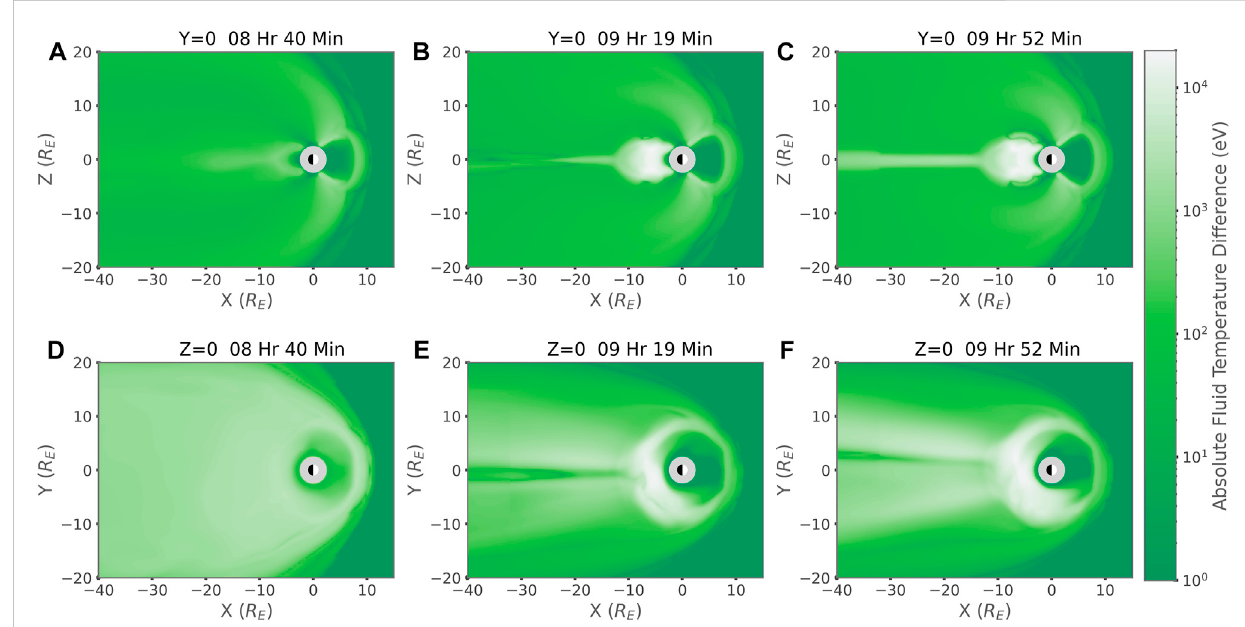
FIGURE 6 Absolute temperature difference of the plasmasphere fl uid and combined solar and polar wind fl uid in the BATS-R-US simulation for the Ideal Square Wave event. Column (A) : 8 h and 40 min into the simulation. Column (B) : 9 h 19 min into the simulation. Column (C) : 9 h 52 min into the